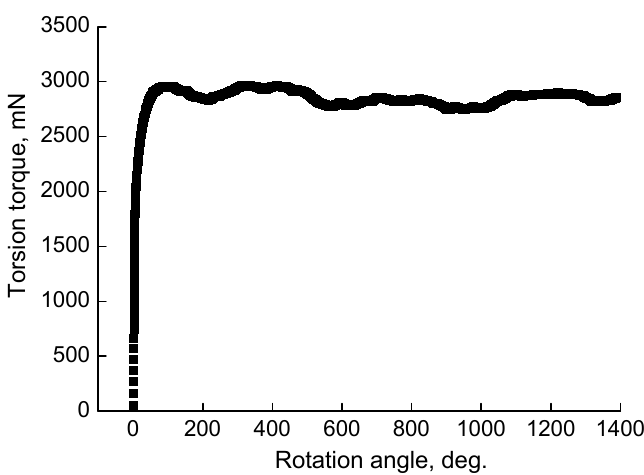
Figure 7. HPT loading curve for the as-cast TiZrHfMoCrCo alloy. Table 4. Phases, lattice parameters, and the percentage of the phases V in the TiZrHfMoCrCo alloy after HPT and HPT plus annealing at 1000 ◦ C.